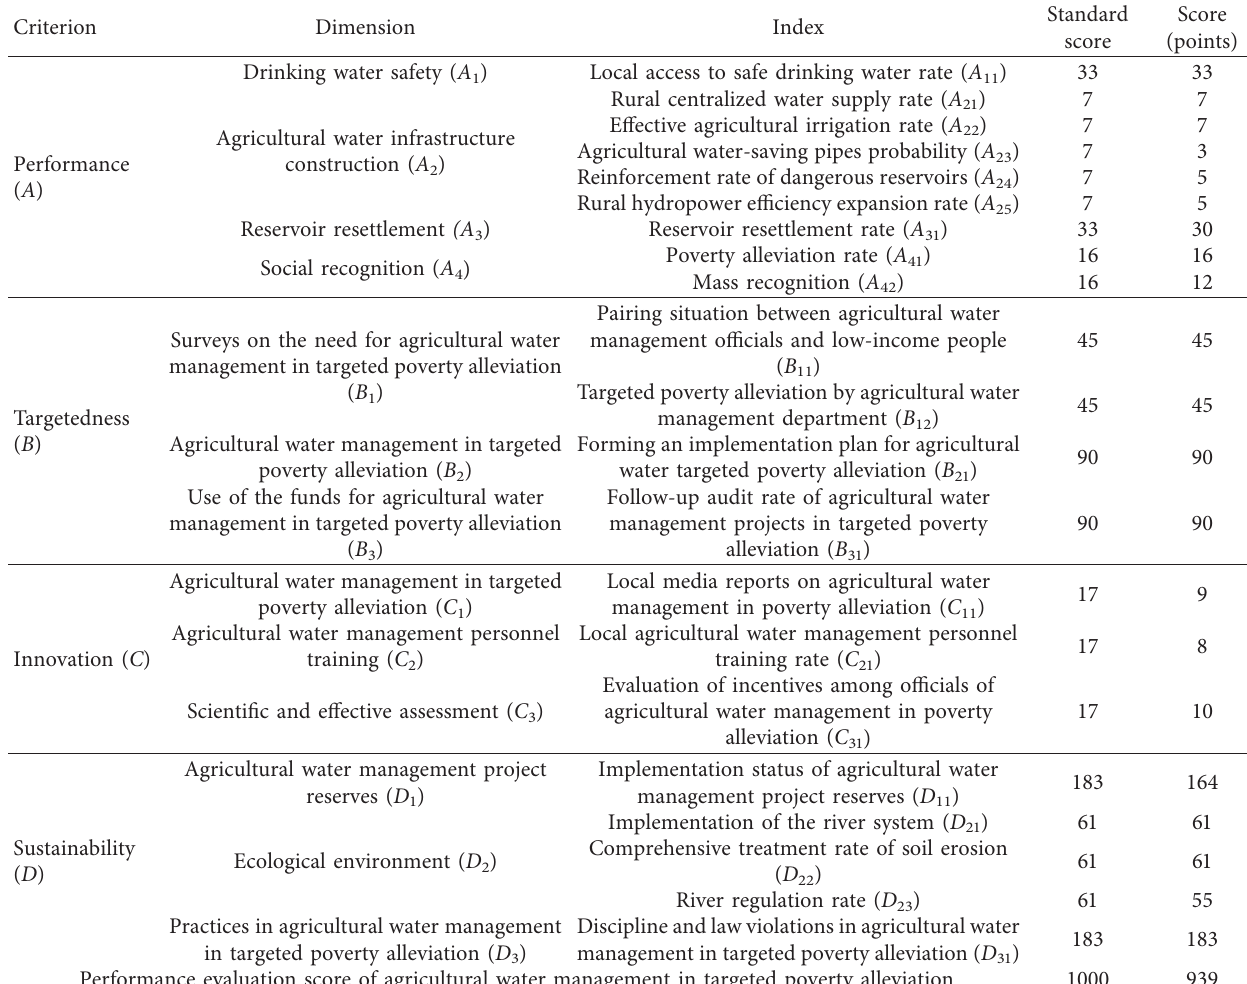
Table 4: Performance scores of agricultural water management in targeted poverty alleviation in a county in the old district of Maoshan in